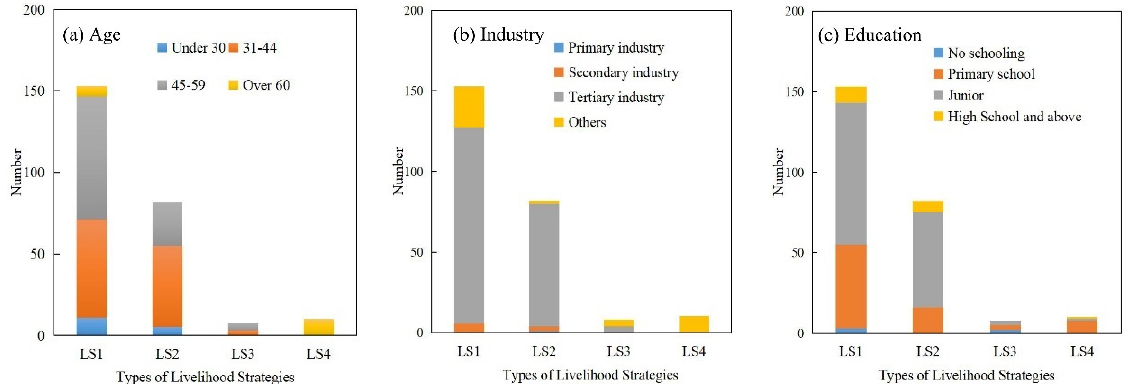
Figure 3. Analysis of fishermen’s livelihood in relation to ( a ) age, ( b ) industry, and ( c )